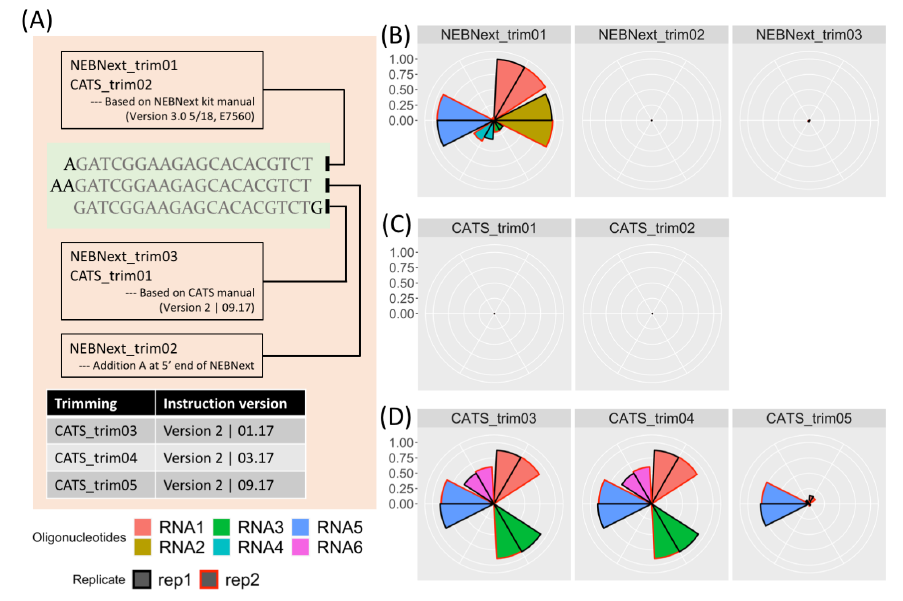
Figure 1. Use of incorrect adapter sequence or trimming protocol can lead to incorrectly trimmed reads and miscounting of reads mapping to features. The selected datasets are originally from [15], samples containing six synthetic small RNAs prepared by the NEBNext and CATS kits. After trimming, the Linux command grep -c was used for counting. ( A ) Top part of figure: Schematic of the different but highly similar adapter sequences used in ( B – D ). Bottom section of figure: Different versions of the CATS manual used for trimming protocol applied in ( D ). Legend under ( A ) Fill colour corresponds to the six synthetic RNAs in the dataset, line colour corresponds to the two replicates for each sample. Sequence for oligonucleotides are listed in Supplementary Table S5. ( B ) Choice of adapter sequence can have a major impact on downstream analysis. Left: Use of the correct adapter sequence (NEBNext_trim01) identifies the presence of 5 out of 6 synthetic small RNAs present in the NGS dataset. Middle and right (NEBNext_trim02 and NEBNext_trim03): Using a highly similar adapter sequence that differs by one or two nucleotides has a drastic effect on mapped reads with less than 1% of reads identified. ( C ) In some case detailed trimming instructions are required in addition to the adapter